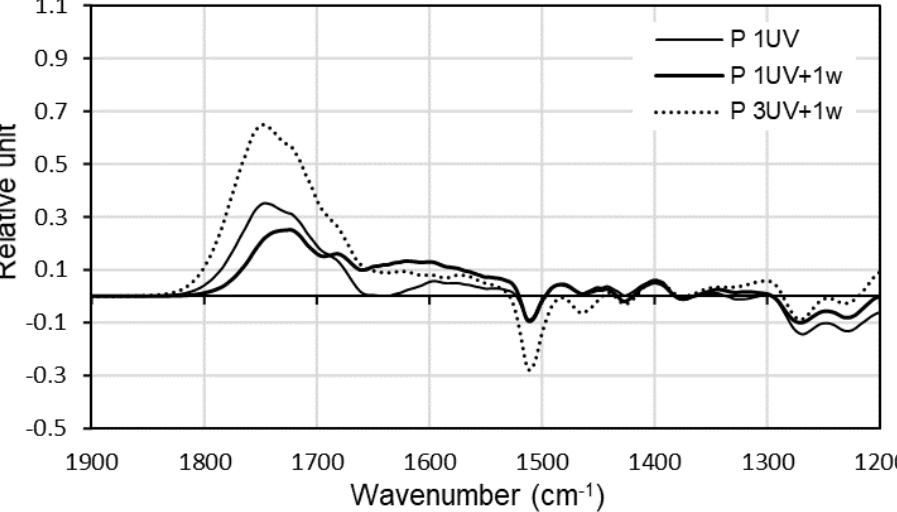
Figure 3. Difference FTIR spectra of Scots pine (P). 1 UV = one-day UV irradiation; xUV + yw is an abbreviation where x is the extent of UV irradiation, and y is the extent of water leaching in days.